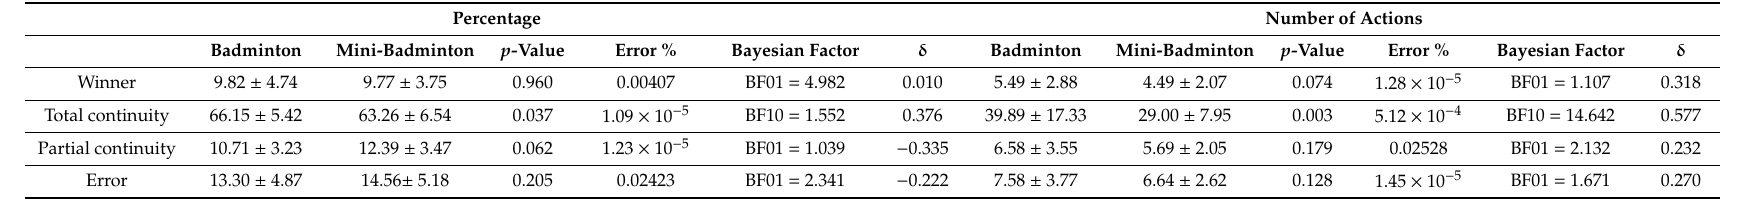
Table 3. Bayesian analysis of usage percentage and stock count technical and tactical in accordance with stroke e ff ectiveness.